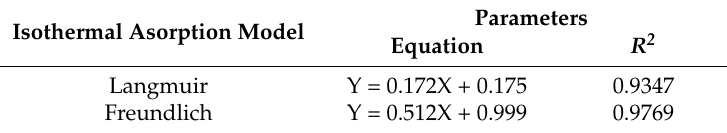
Figure 9. Linear fitted curve of Langmuir isothermal adsorption model ( a ), linear fitted curve of Freundlich isothermal adsorption model ( b ), and nonlinear fitted curve of Freundlich isothermal adsorption model ( c ) of ECB-MICMs. Table 2. Adsorption isotherm parameters of